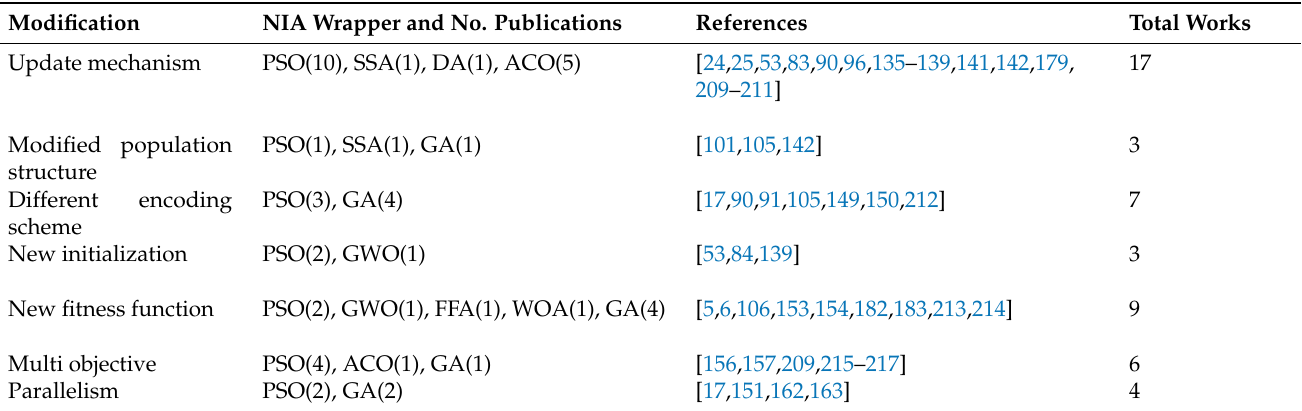
Table 3. Summary of main studies in the literature that adopted the remaining modifications techniques for NIAs-FS.